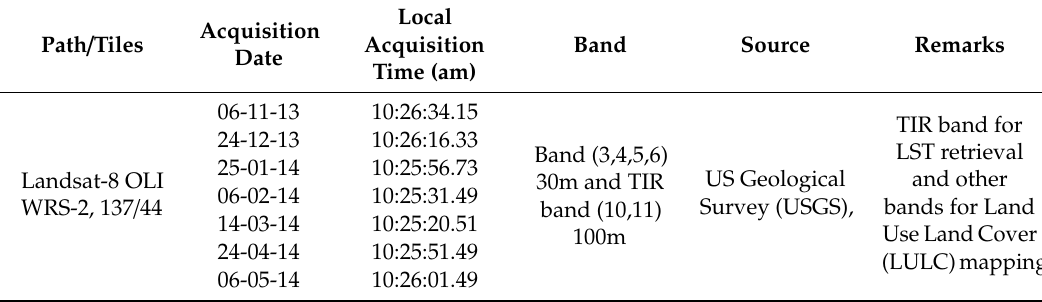
Table 2. Summary of Landsat-8 Operational Land Imager (OLI) used in this research.